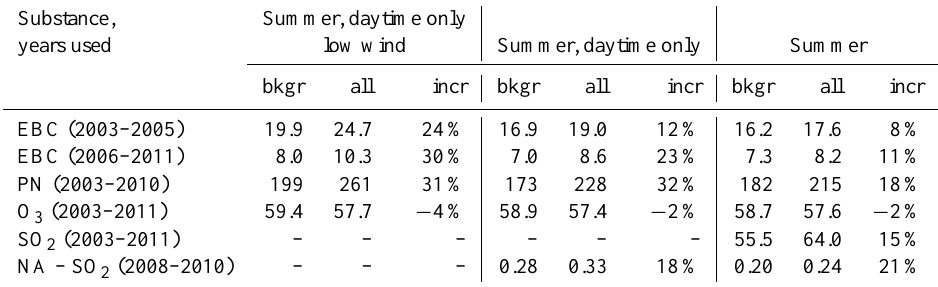
SO 2 ) [µgm − 3 ] when periods with ship influence were filtered out (“background”, bkgr) and for the entire data set (all), for various averaging time periods. Relative increases (incr) over the background periods are given in